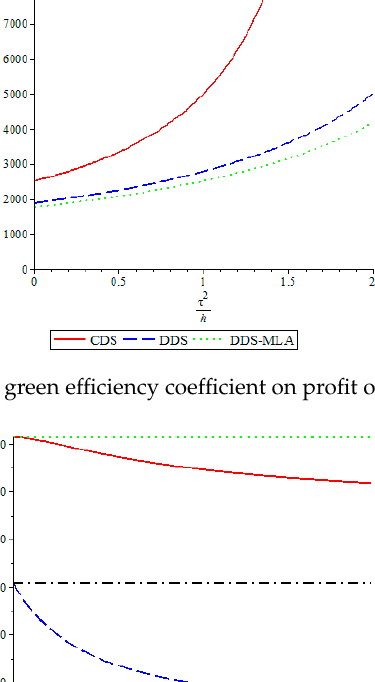
Figure 9. The impact of loss-aversion coefficient on manufacturer’s profit and retailer’s profit.